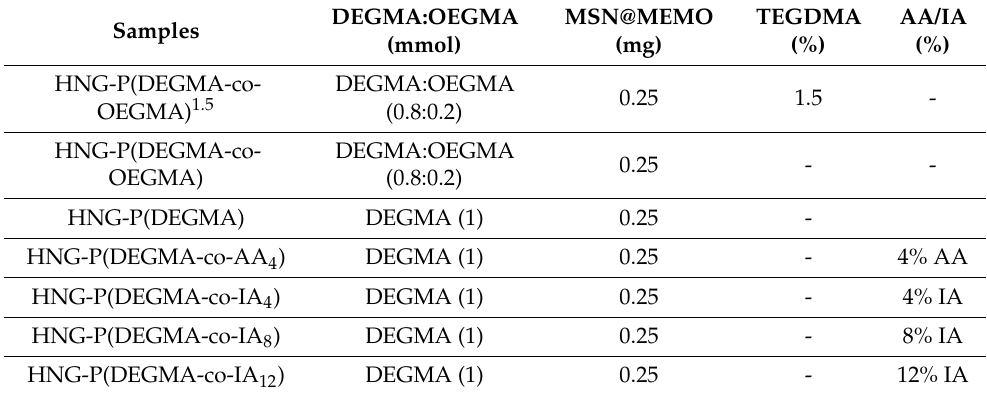
Table 1. Summary of the reaction conditions of synthesized